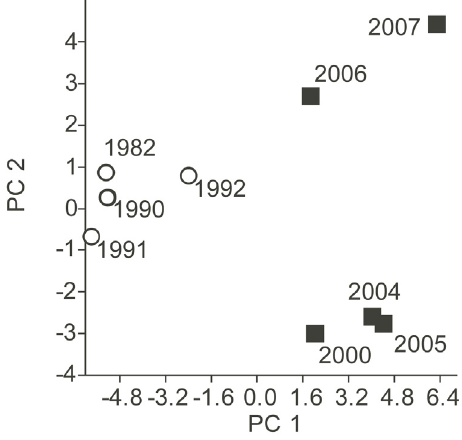
Figure 5. Principal component analysis ordination of Bray–Curtis community similarities based on the 7-taxon matrix of average summer phytoplankton counts for the inner bay of Green Bay. The first two principal components account for 90.4% of the total variation of the community similarities. Open circles indicate the pre-invasion years (1982–1992), filled squares show post-invasion years (2000–2007).